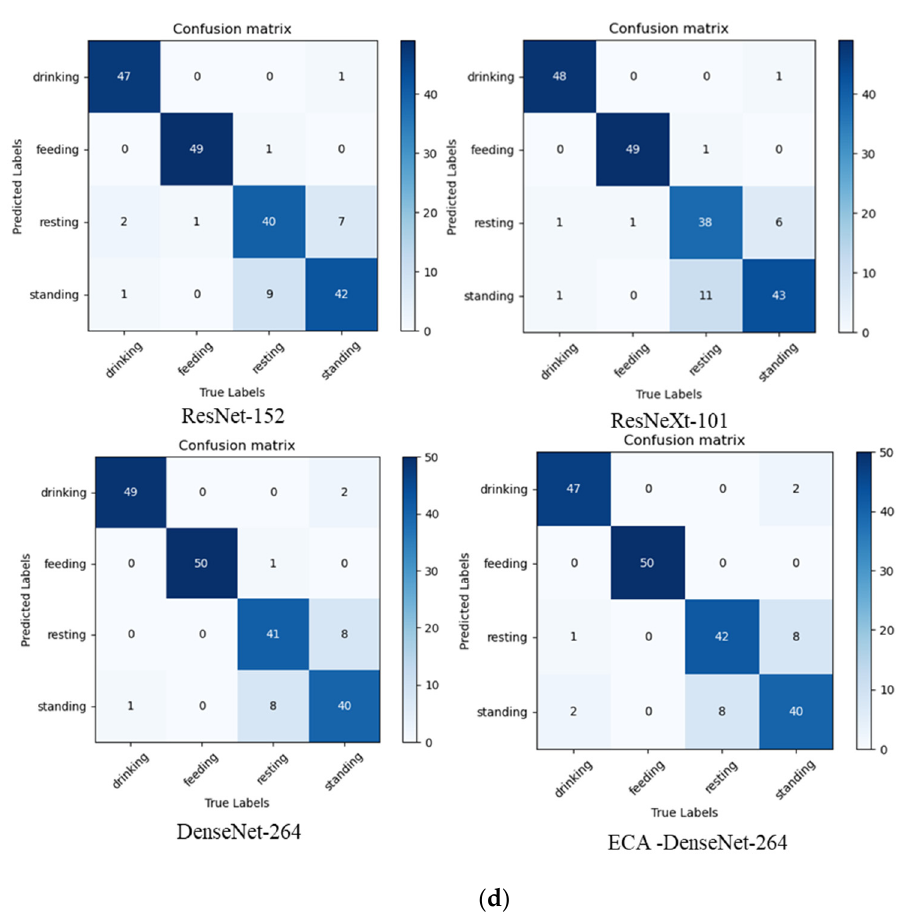
Figure 2. Confusion matrix of detection results on d2 ( a ), d9 ( b ), d16 ( c ), and d23 ( d ) datasets.